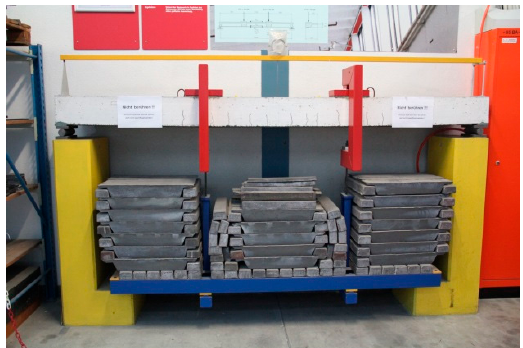
Figure 13. Dimension and measurements of the long-term beam test.